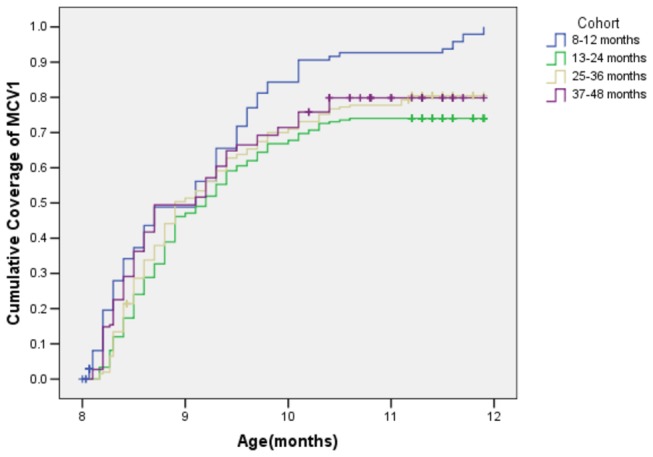
Cumulative coverage of MCV1(%) for different cohorts.According to immunization cards by month of age in the four cohorts of children aged 8-12 months(blue line), 13-24 months(green line), 25-36 months(yellowe line) and 37-48 months(purple line). Number of children in each cohort is 108, 208, 201 and 182, respectively.